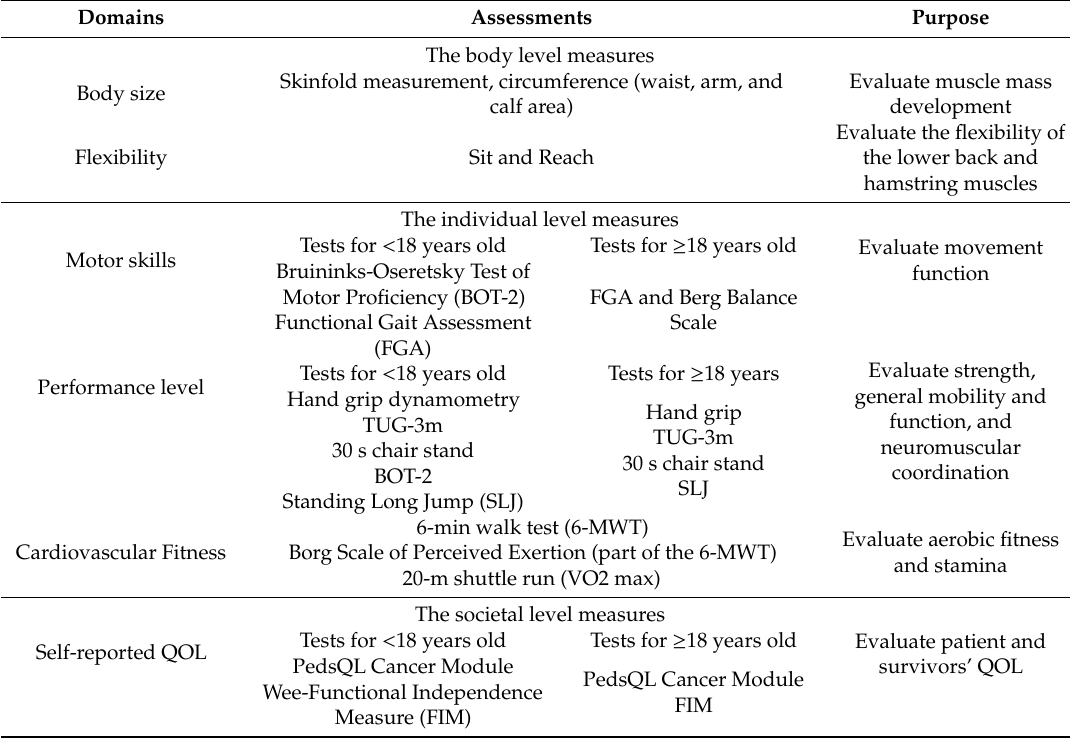
Table 1. Summary of domains being measured and the associated assessments